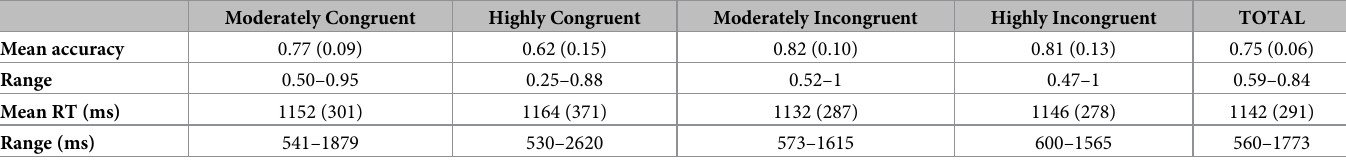
Table 1. The means and ranges of Numerosity Comparison performance (accuracy, RT) in each condition.